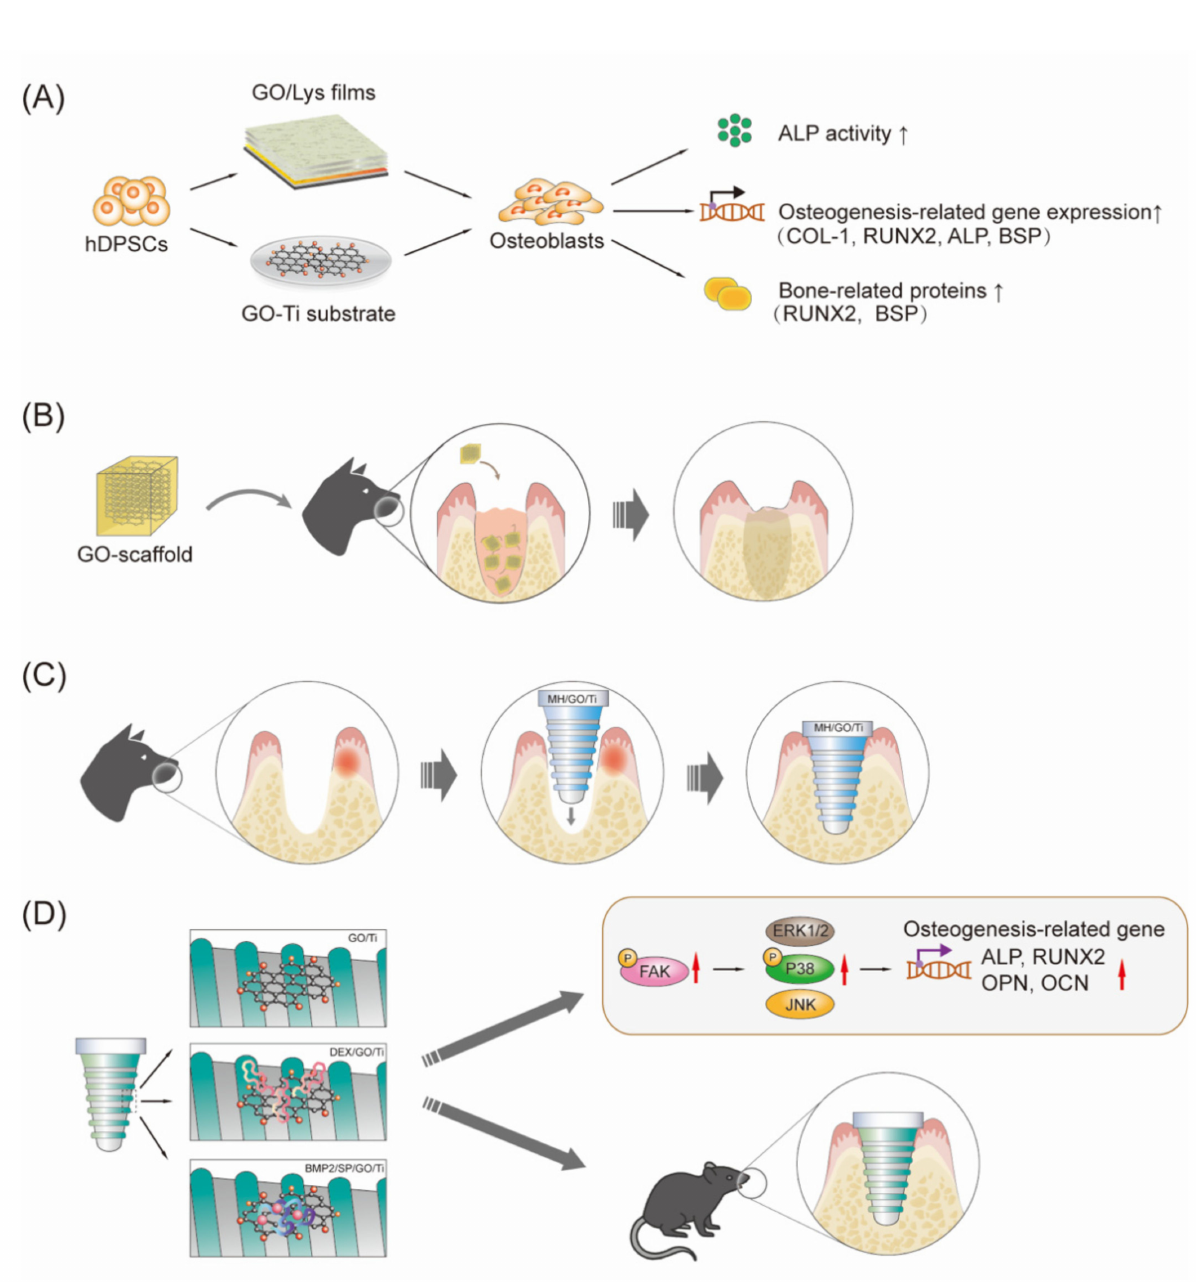
Figure 4. Graphene-based materials possess great potential to facilitate bone regeneration in dentistry. ( A ) Graphene-based materials (e.g., GO and lysozyme (GO/Lys)8 films on Ti substrate, GO coated Ti substrate) induce PDLSC proliferation and osteogenic differentiation in vitro. ( B ) Implantation of the GO–3D collogen sponge-form scaffold (GO–scaffold) in the tooth extraction socket enhances the formation of new bone. ( C ) Ti implants with MH-loaded GO films (MH/GO/Ti) show good therapeutic effects for peri-implantitis and can prevent its further development in beagle dogs, exhibiting a significantly reduced modified sulcus bleeding index, marginal bone loss and peri- implant probing pocket depth, and many osteocytes but almost no neutrophils. ( D ) GO coating on the Ti surface facilitates bone marrow-derived mesenchymal stem cell osteogenic differentiation by activating intracellular FAK and its downstream MAPK/P38 signaling pathway to upregulate the expression of genes associated with osteogenesis (such as ALP, OPN, RUNX2 and OCN) and enhance bone-implant osseointegration in vivo. The loading of dexamethasone (DEX) (DEX/GO/Ti), bone morphogenetic protein 2 and/or substance P (BMP-2/SP/GO/Ti) can enhance the above effects. The black arrow indicates promote; the red arrow indicates upregulation. PDLSCs, periodontal ligament stem cells; MH, minocycline hydrochloride; FAK, focal adhesion